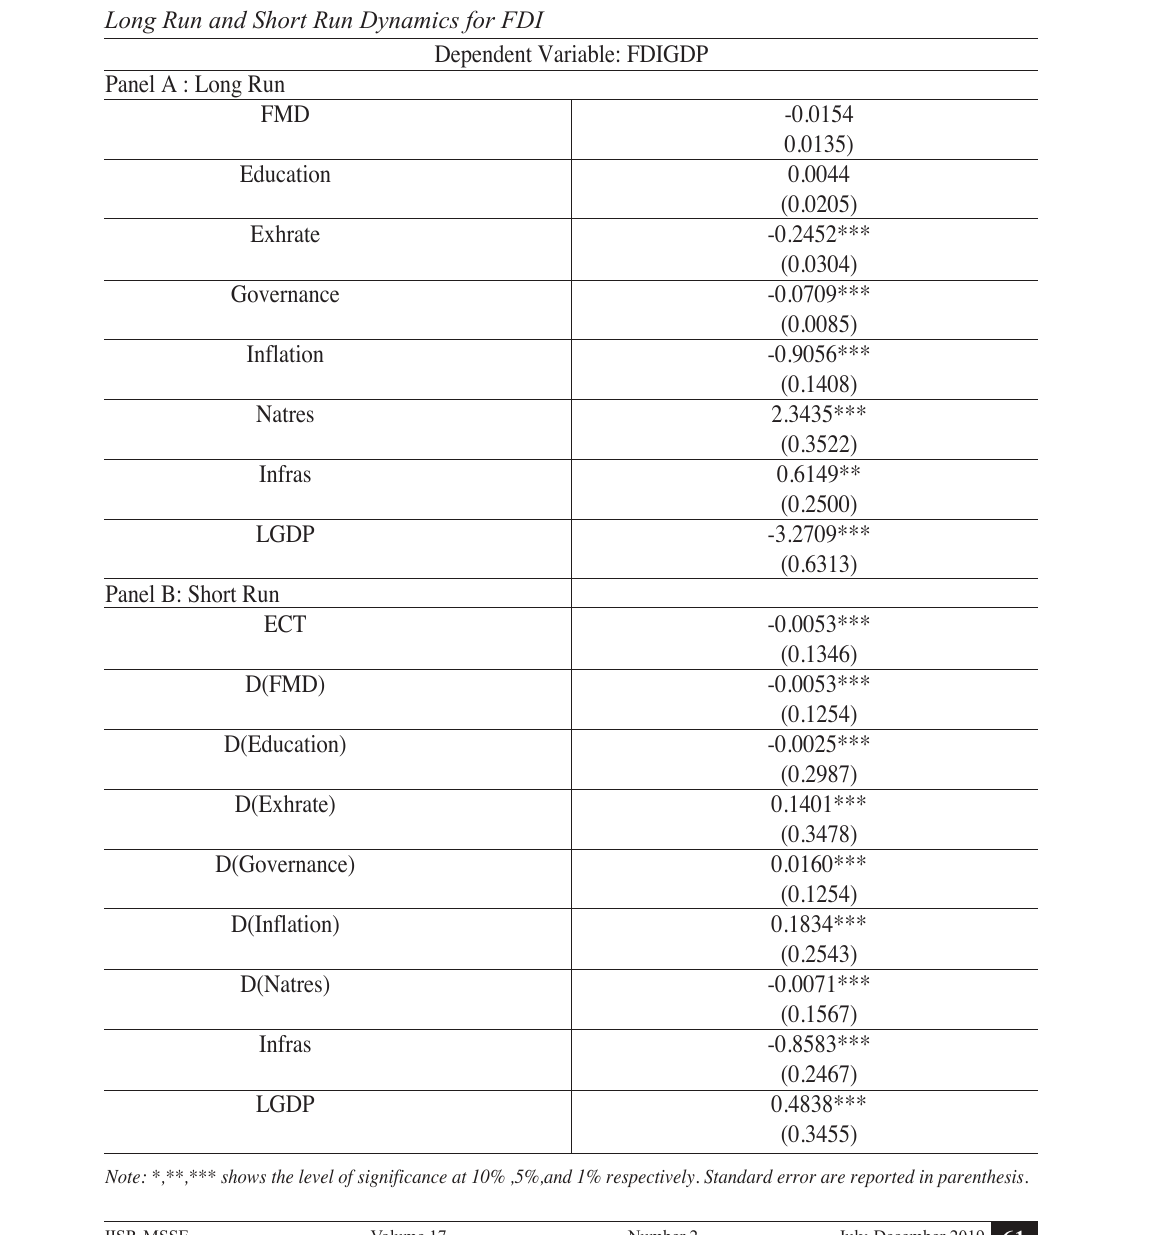
Dependent Variable: FDIGDP